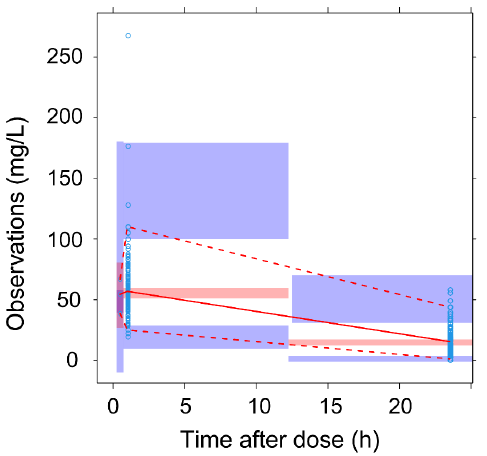
Figure 3. Visual predictive check (VPC) of the final model. Empty circles: observed data; red solid line: median of observed data; red dashed lines: 5th and 95th percentiles of observed data; pink area: 95% confidence interval around the median of simulation; purple areas: 95% confidence in- terval around 5th and 95th percentiles of simulation. The external validation was performed running the model using the validation da- taset. Because of the reduced size of the dataset, it was not possible to execute a VPC, but the NPC coverage plot (Figure 4B) ruled out abnormal trends in the DV/iPRED ratio.